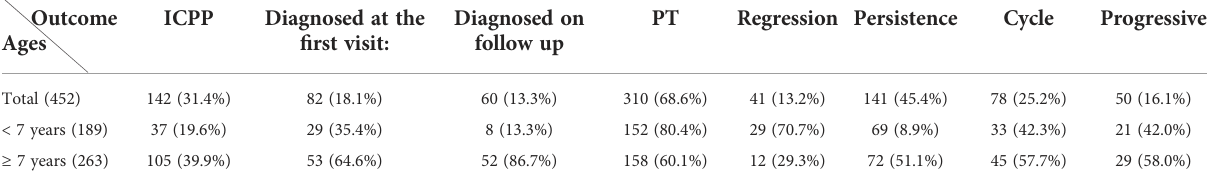
TABLE 1 Outcomes in girls with early breast development. Outcome Ages